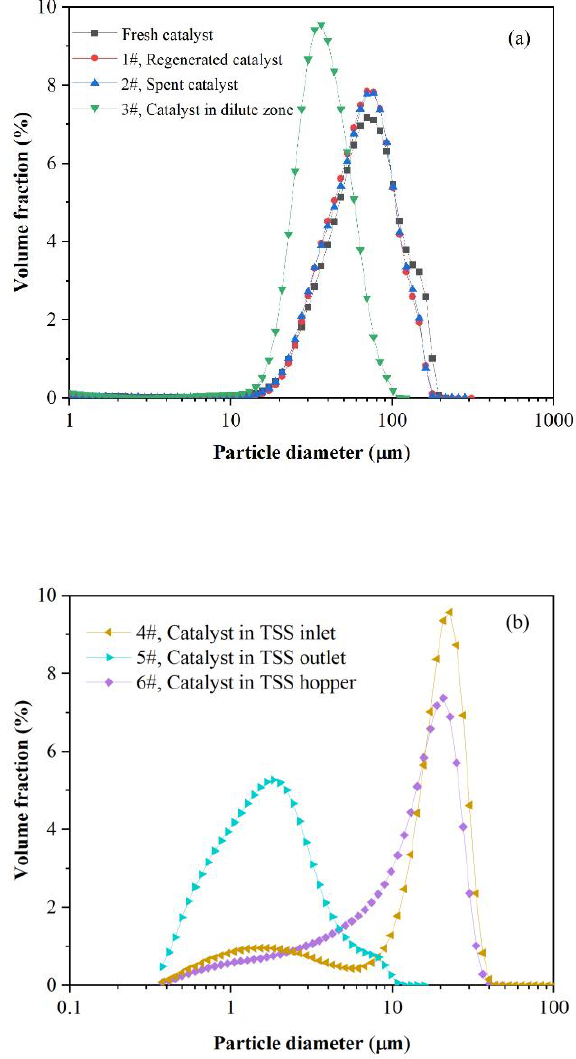
Figure 2. PSD of the catalyst samples ( a ) in the reactor and regenerator and ( b ) collected in the downstream of the regenerator. Table 1. Characteristic sizes of catalyst samples.